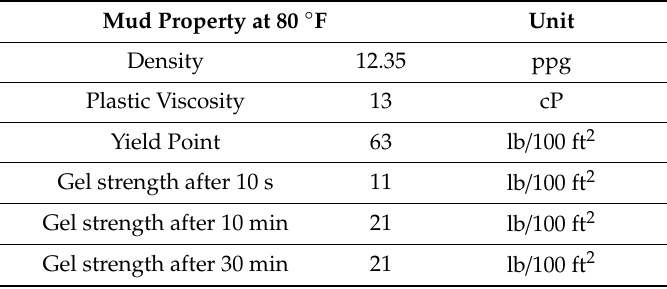
Table 3. Mud Properties at 80 ◦